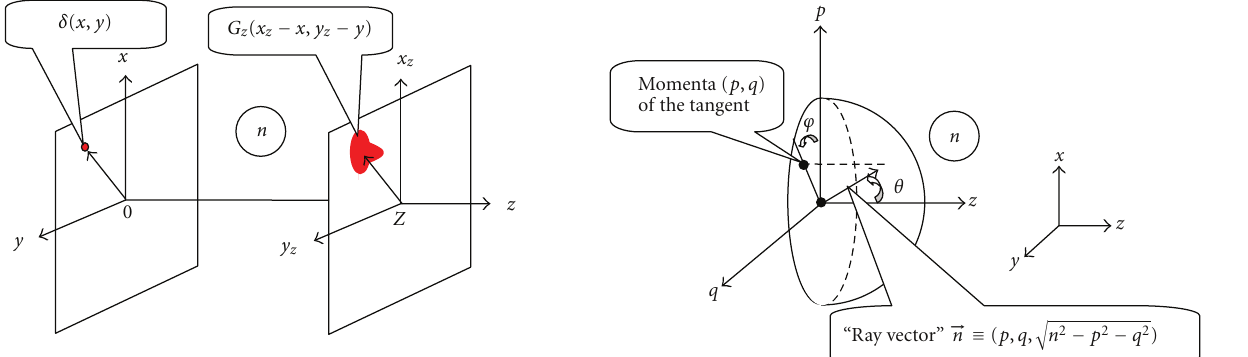
Figure 3: A layer of an optically homogeneous medium as a linear system. Figure 4: Direction of the “ray vector” can be characterized by angles ( θ , ϕ ) of the spherical coordinate system ( ϕ ∈ (0,2 π ), θ ∈ (0, π/ 2)), or by momenta ( p , q